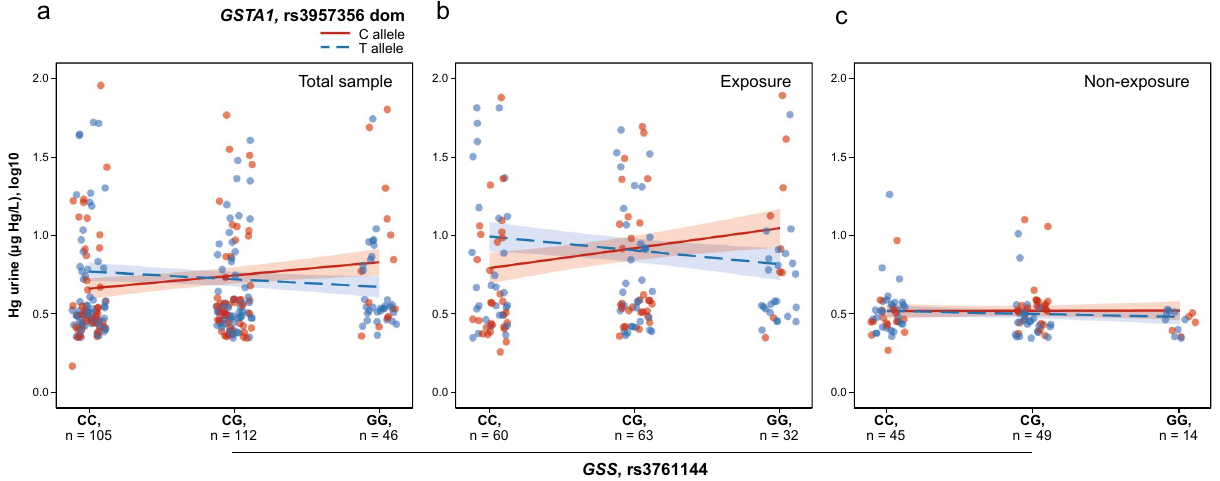
Figure 2. Interaction effects of genetic variants in a multivariable model of urine-Hg. The urine-Hg concentration was defined as a function of the interaction between GSS rs3761144 under an additive model and GSTA1 rs3857356 under a dominant model. The interaction plot shows a significantly increasing trend of urine-Hg levels when individuals carry both rs3761144-G and rs3957356-C alleles ( P = 0.015, P perm = 0.017) in the total sample ( a ). A simple slope analysis showed that the association between urine-Hg and GSS rs3761144 was stronger in individuals with rs3957356-C allele compared to individuals with rs3957356-T allele in the exposed group (β = 0.13, P = 0.04) ( b ) but not in the non-exposed group ( c ). All interaction analyses were adjusted by age, sex, eGFR, and hair-Hg levels (µg Hg/g hair). Total sample was also adjusted by exposure status.